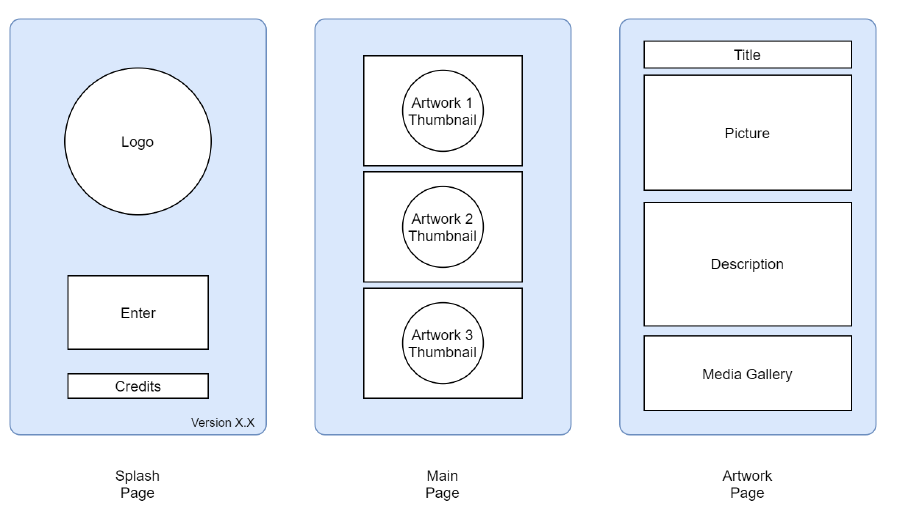
Figure 3. Blueprints of the three views composing the app UI